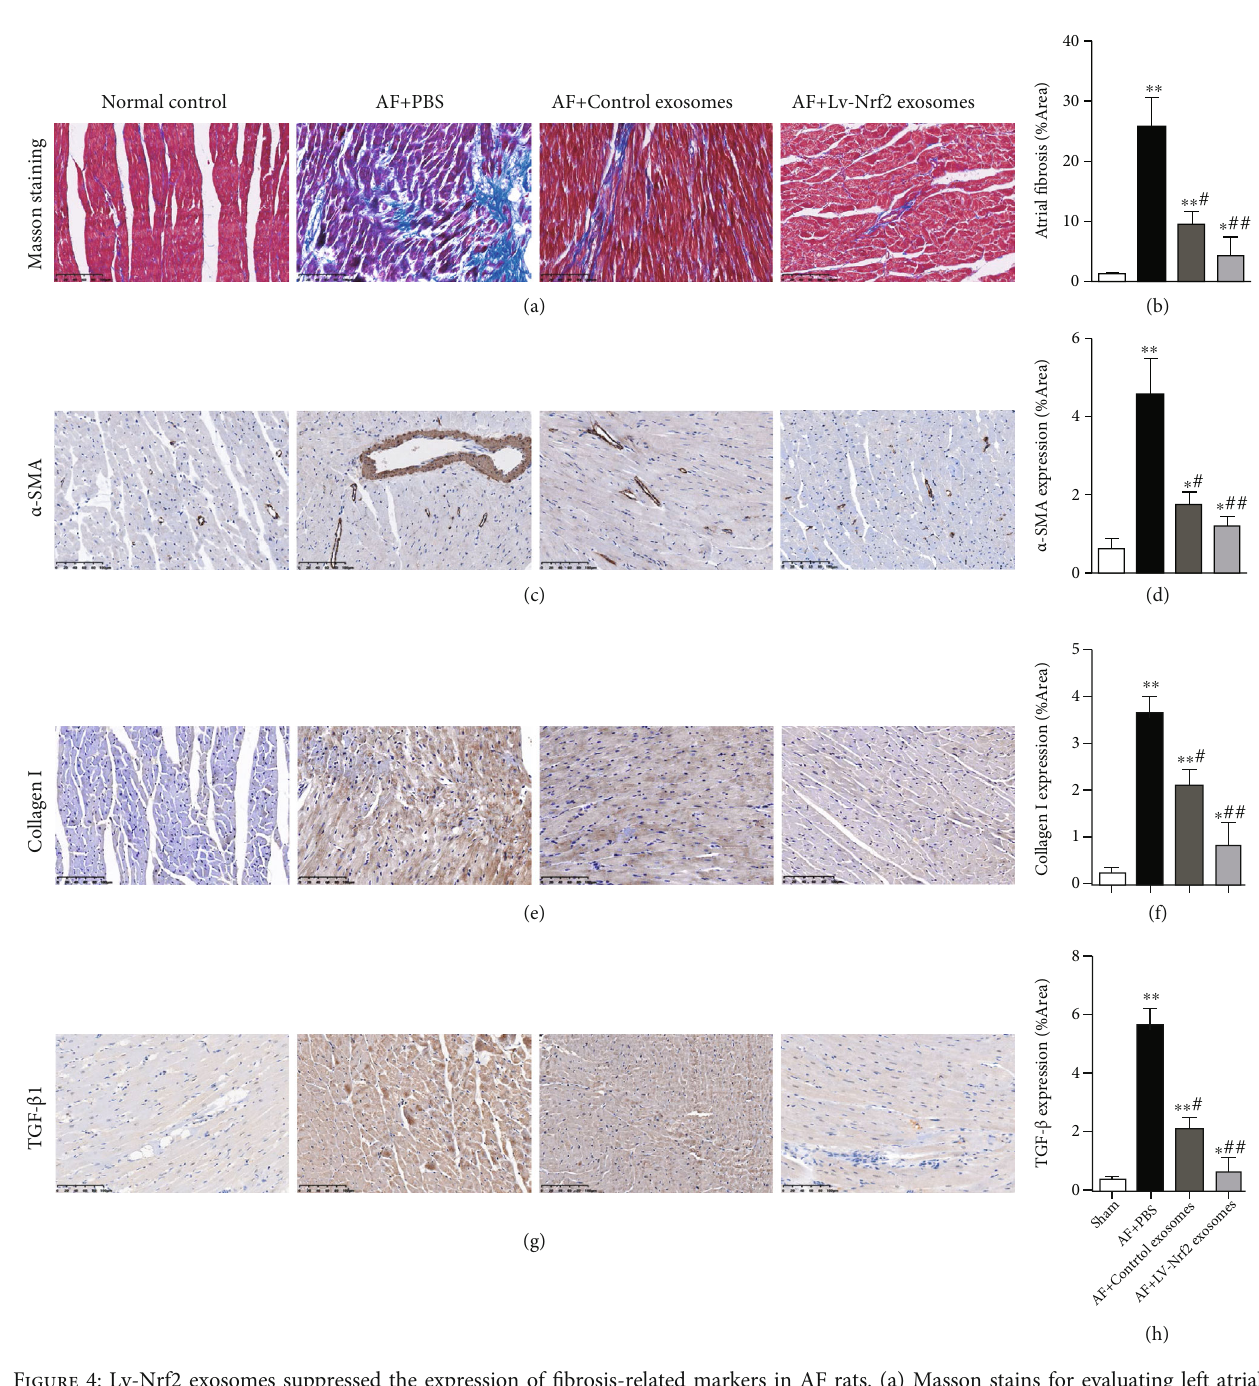
Figure 4: Lv-Nrf2 exosomes suppressed the expression of fi brosis-related markers in AF rats. (a) Masson stains for evaluating left atrial fi brosis within rats from each group. Scale = 100 μ m . (b) Quanti fi cation for the atrial fi brosis region. (c – h) The representative immunohistochemical staining and quantitative analysis showing the expression of atrial fi brosis makers α -SMA (c, d), collage I (e, f), or TGF- β 1 (g, h) in the heart of the rats. Scale = 100 μ m . n = 5 /group. Results re fl ected mean ± SD . ∗ P < 0 : 05 , ∗∗ P < 0 : 01 in comparison to the control group. # P < 0 : 05 , ## P < 0 : 01 in comparison to the AF+PBS